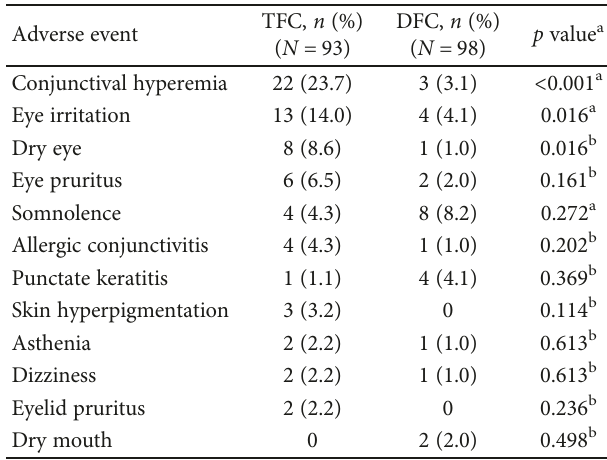
Table 3: Responder analyses: percentage reduction in IOP from baseline and mean IOP levels achieved a .